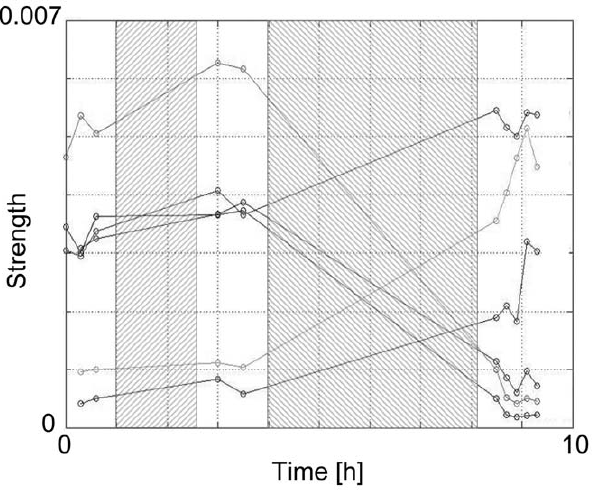
Figure 5. Strengths of persisting connections during one of our experiments. In this experiment there were only 6 persisting functional connections and the development of their strengths is represented by the 6 lines. The experiments had 5 phases. White areas: spontaneous activity recordings. left hatched area: random stimulation (see section II.B). Right hatched area: training protocol (see section II.C). The graphs illustrate that the strength of most individual connections was affected by the protocol. In total, the strength of 64% of all persisting connections was significantly changed. The figure also suggests that global parameters like mean strength may not be affected by the protocol. Figure 4. Development of the number of required stimuli during training experiments. A shows a typical example of an individual ‘learning curve’, as observed in 5 of 10 experiments. B depicts N , mean 6 SD) of all 10 experiments. On the average development ( average the number of applied stimuli decreases significantly with trial Nr. (Kendall’s tau: Correlation coefficient: 2 0.33; P , 0.01).